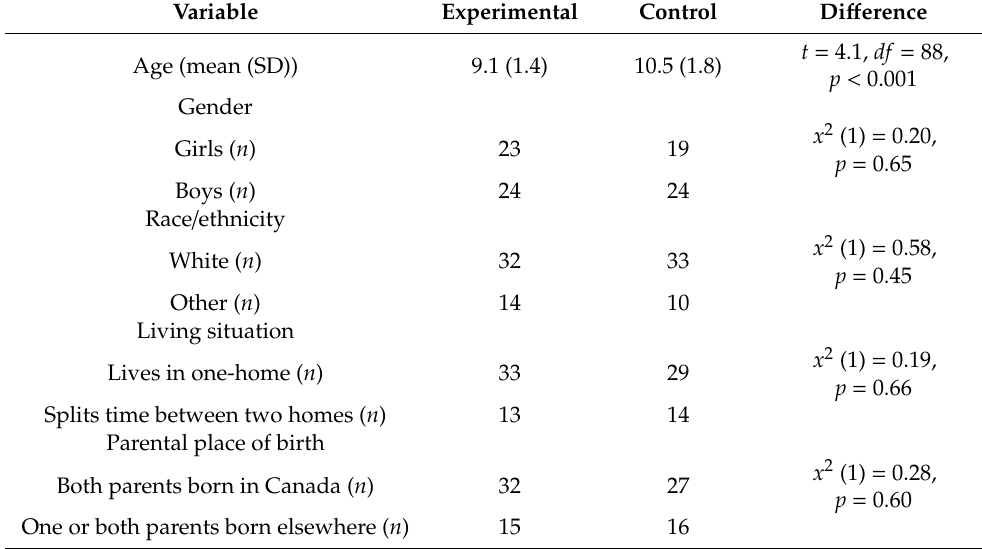
Table 3. Demographic characteristics of the participating children at